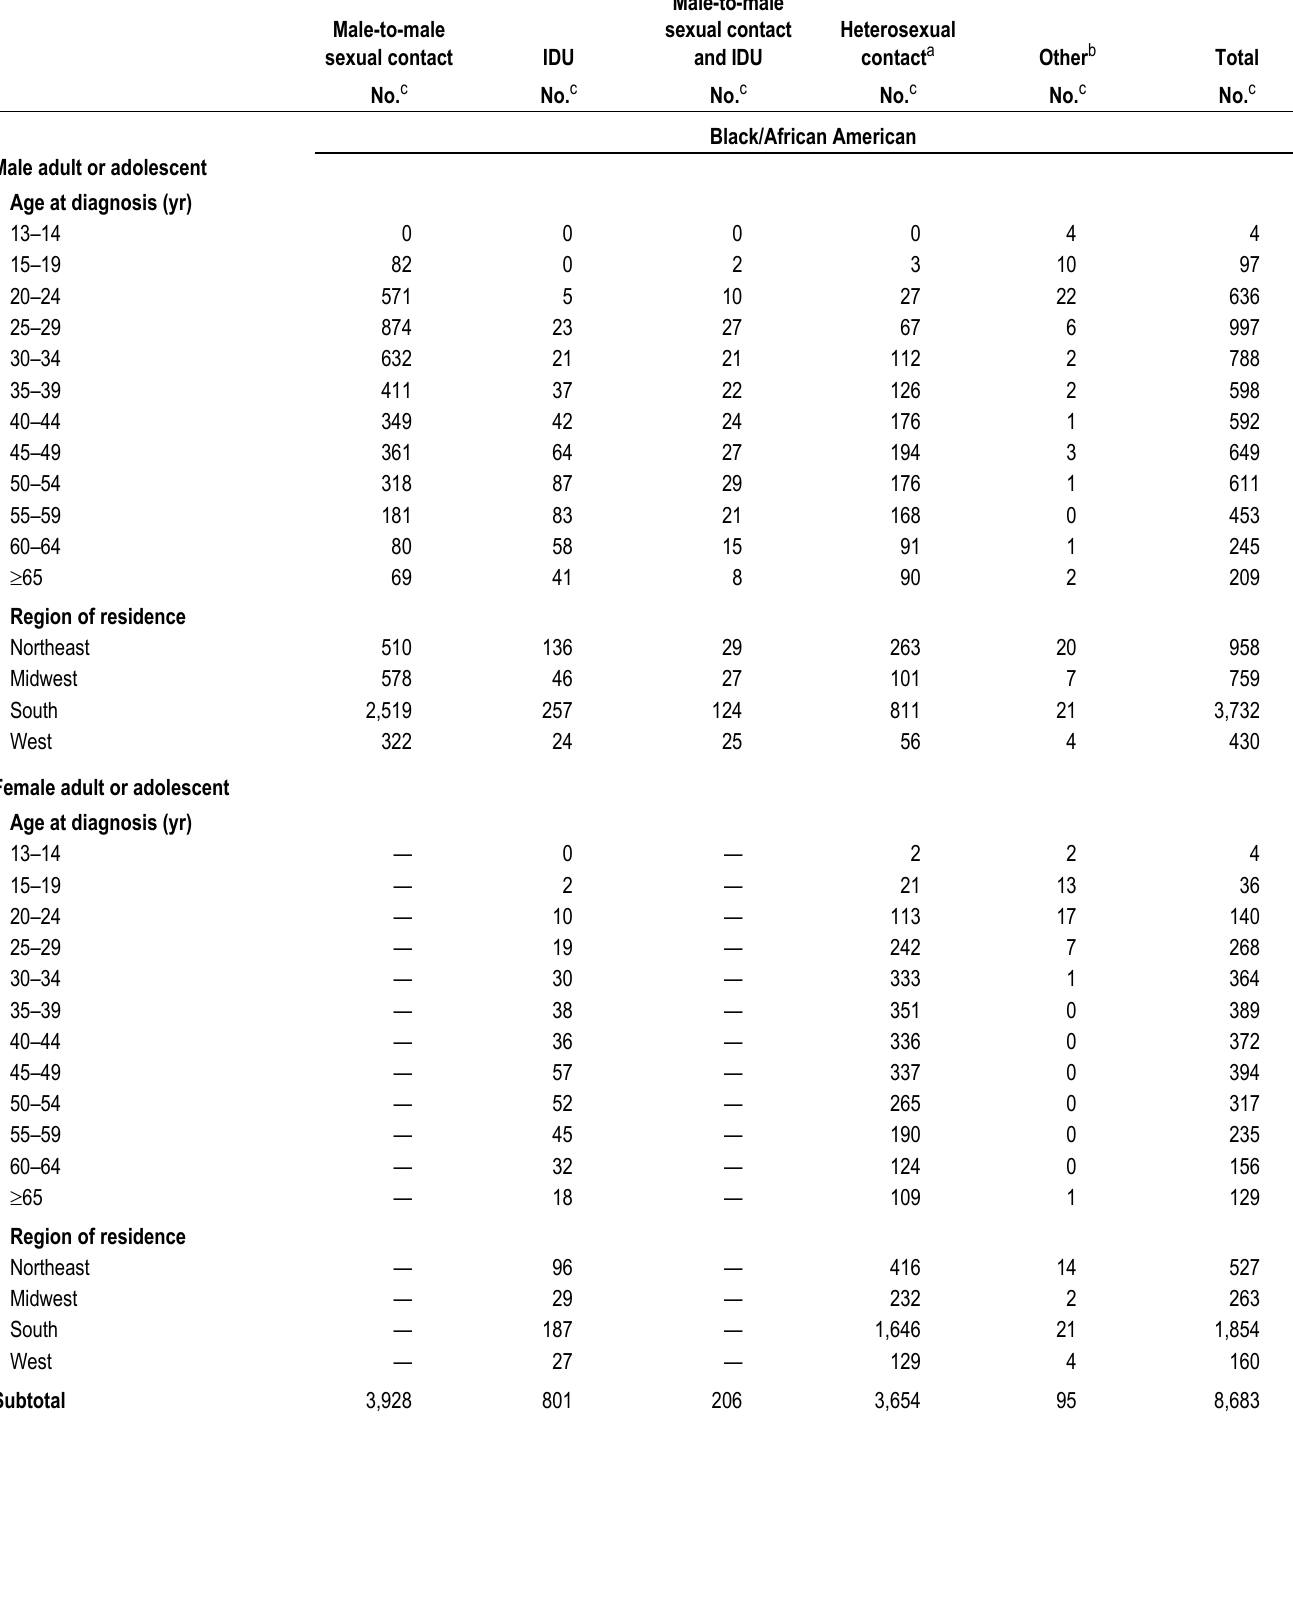
Table 6a. Stage 3 (AIDS), by transmission category, race/ethnicity, and selected characteristics, 2015—United States